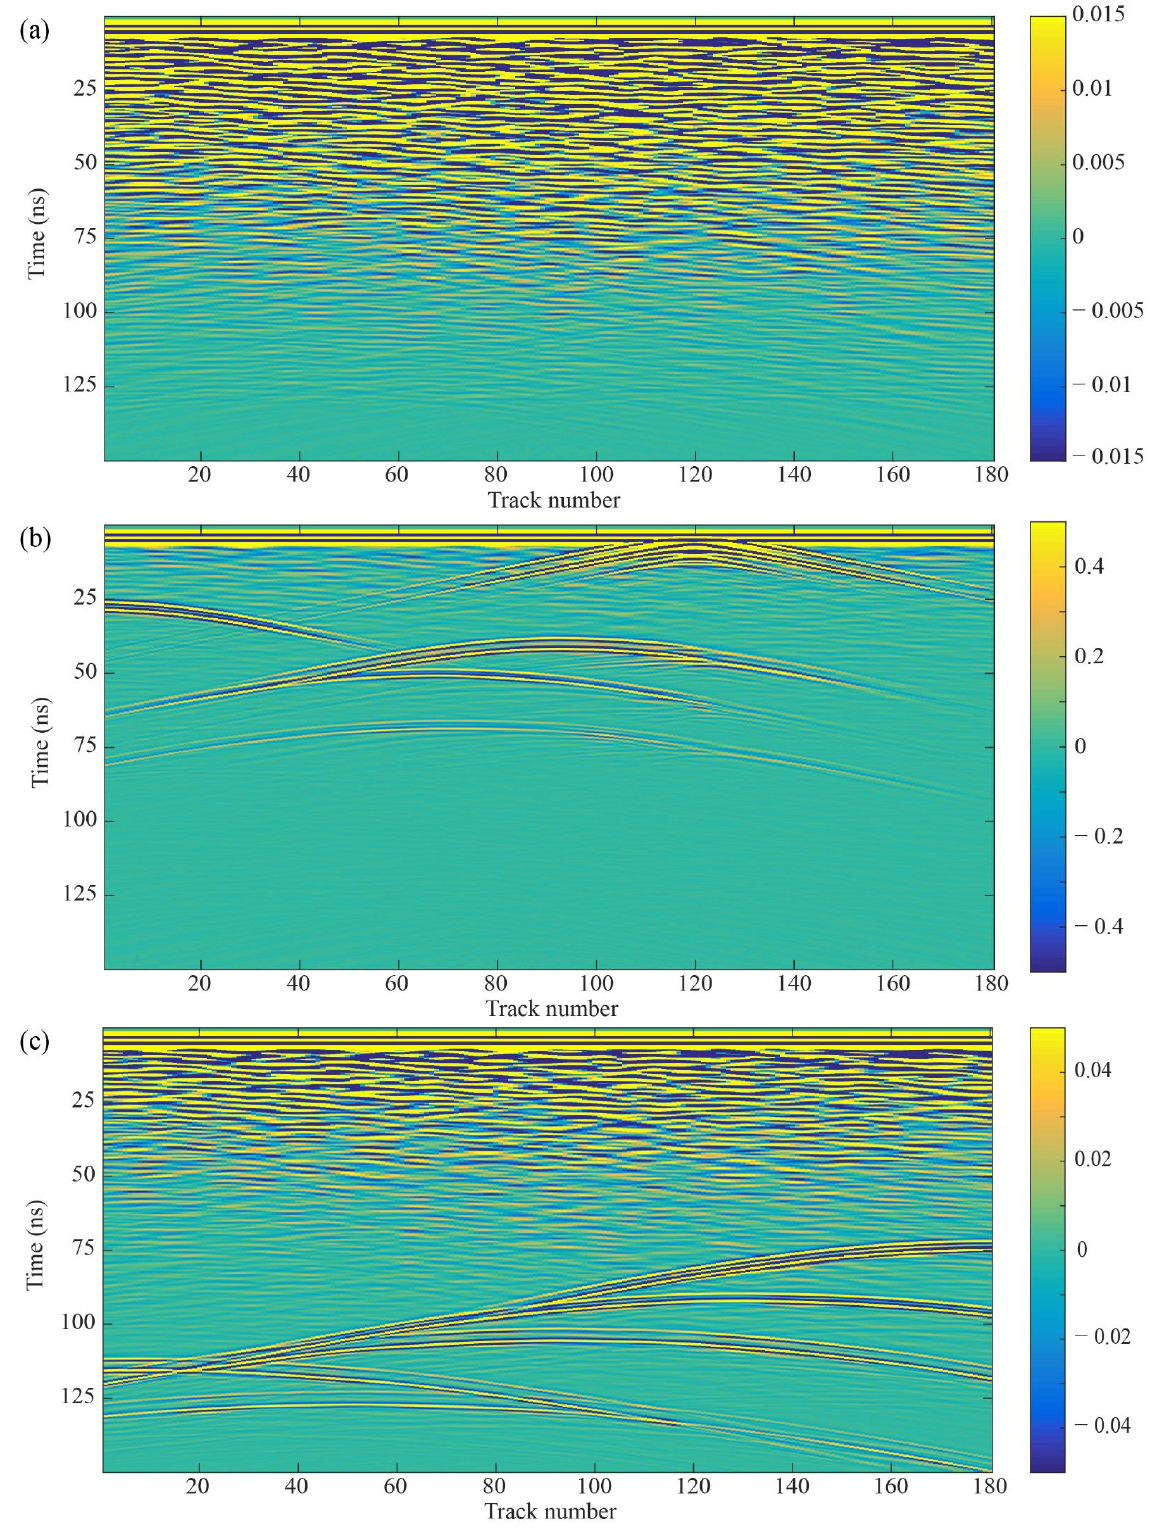
Figure 4. Simulation results of three stochastic media models. ( a ), ( b ) and ( c ) are the simulation results of Models One, Two and Three in Figure 3,